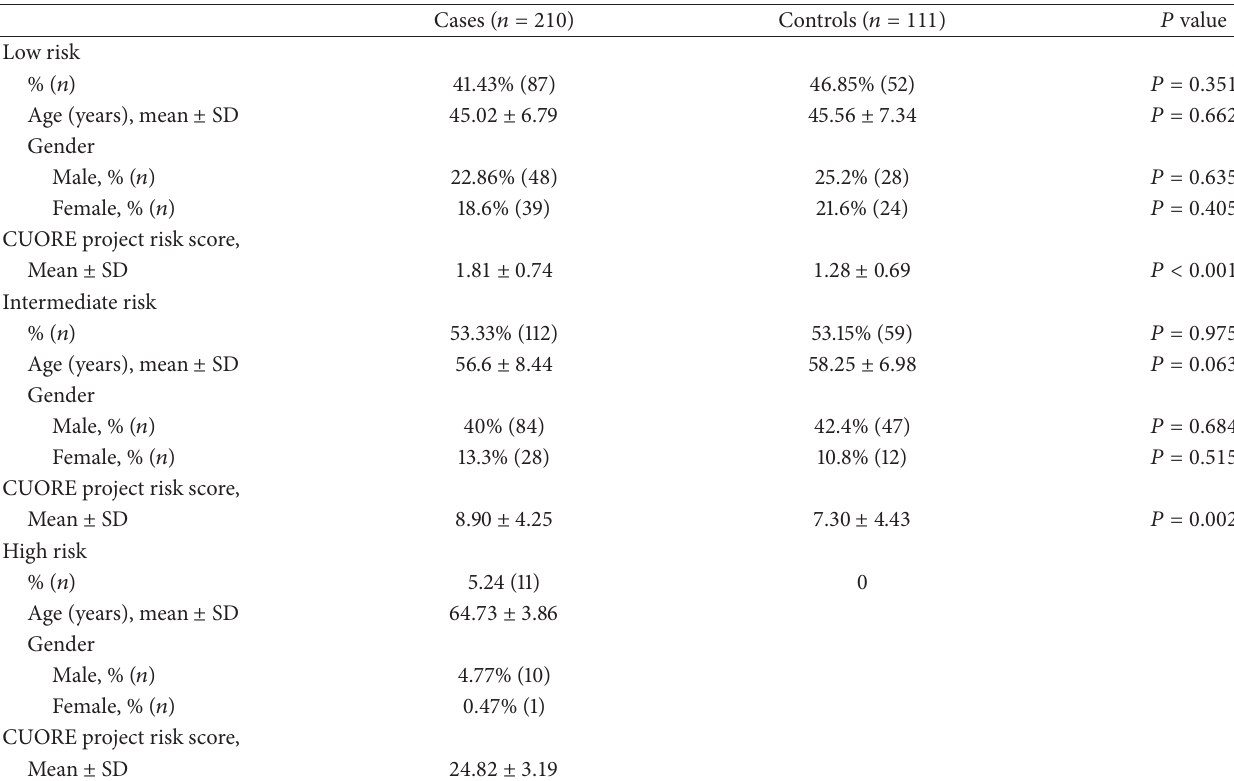
Table 2: Comparison of CUORE project risk score in patients and